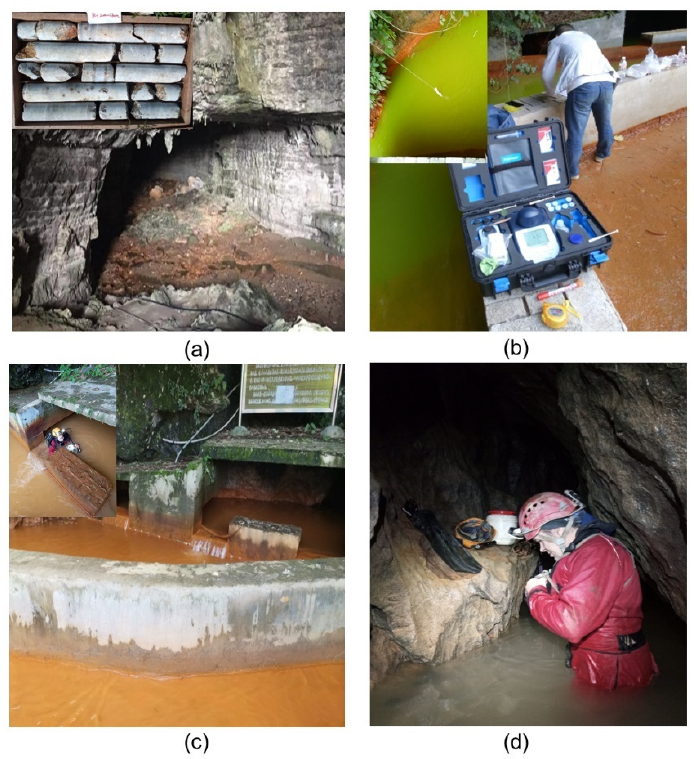
Figure 3. Investigation methods: ( a ) karst core sample from borehole YR-1; ( b ) water quality detection; ( c ) pollution in the Longdong Spring; ( d ) diving exploration in Sinkhole No.5.